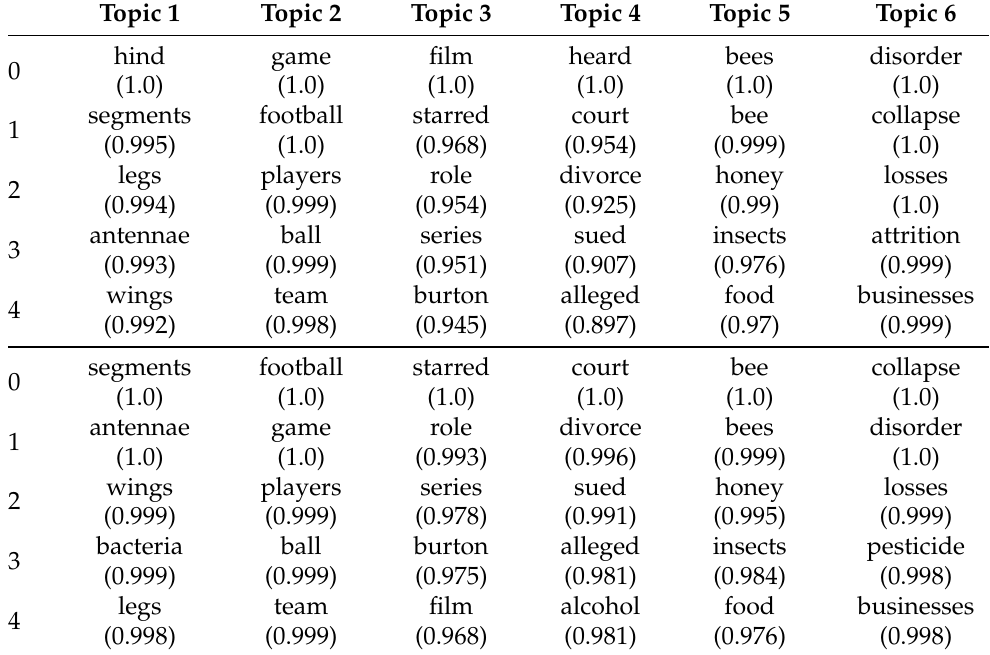
Table 9. For the most significant two words per topic, the four nearest neighbors based on cosine similarity are listed. Matrix A (cid:48) , trained on the wikipedia data as input tensor using automatic gradient methods.